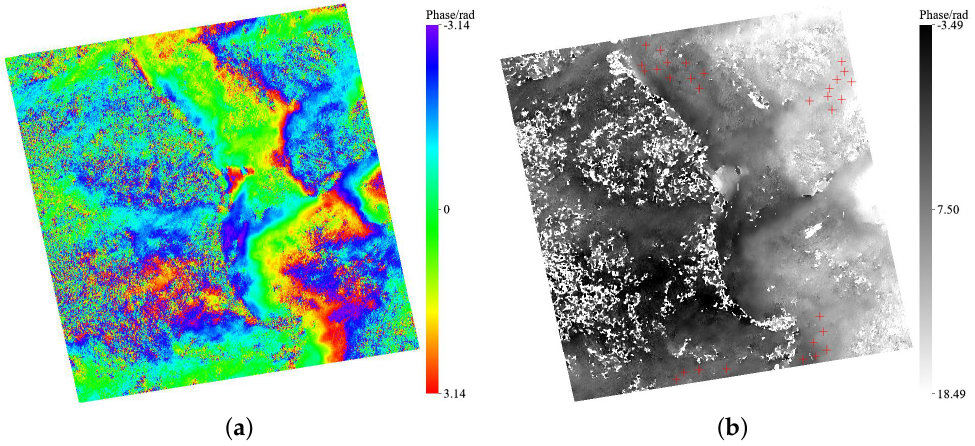
Figure 5. ( a ) Filtered interferogram, which is used for determining terrain and deformation areas. ( b ) Unwrapped interferogram with 30 GCPs. The red plus sign represents GCPs.